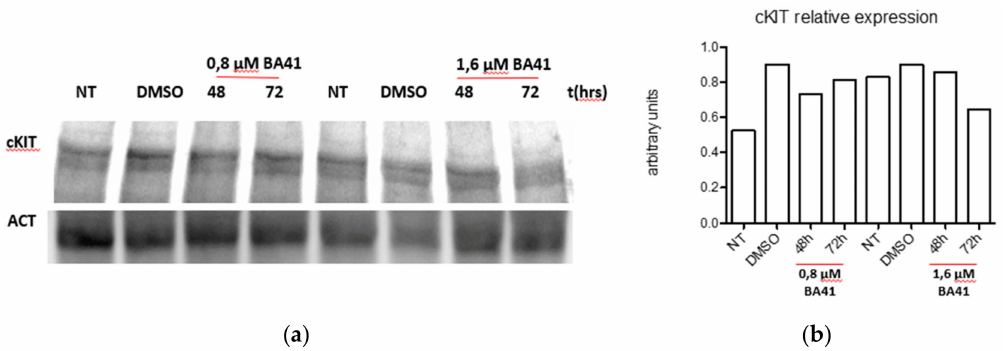
Figure 10. ( a ) Western blot analysis representing c- KIT expression in SU-DHL4 cells treated with BA-41 ( 2 ) (0.8 and 1.6 µ M). β -actin was used as an endogenous normalizer of the amount of loaded proteins. ( b ) Densitometric analysis performed using ImageJ software (http: // rsbweb.nih.gov / ij /